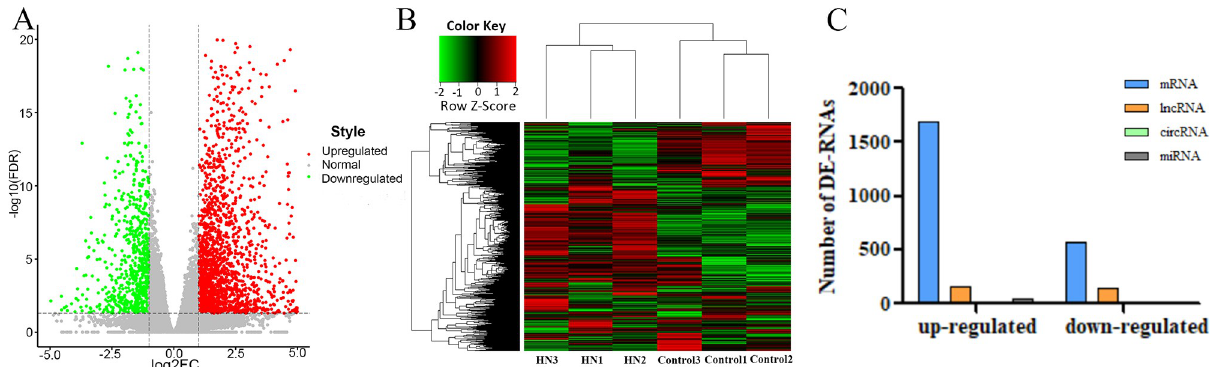
Fig 3. Characteristics of all DE-transcripts. (A) Volcano plot of all DE-transcripts between the rats suffering from HN and normal control rats. Red nodes refer to transcripts that were upregulated [log2 (fold change) > 1, FDR < 0.05], while green nodes represent transcripts that were downregulated [log2 (fold change) < -1, FDR < 0.05]. Grey points indicate normally expressed transcripts. (B) The DE-transcripts in HN were analysed via hierarchical clustering. The closer to a red colour, the higher of expression. In contrast, a green denotes downregulated expression profiles. (C) Characteristics of DE-transcripts. Blue, orange, green and grey colours denote mRNAs, lncRNAs, circRNAs and miRNAs, respectively. HN, hyperuricaemic nephropathy; FDR, false discovery rate.